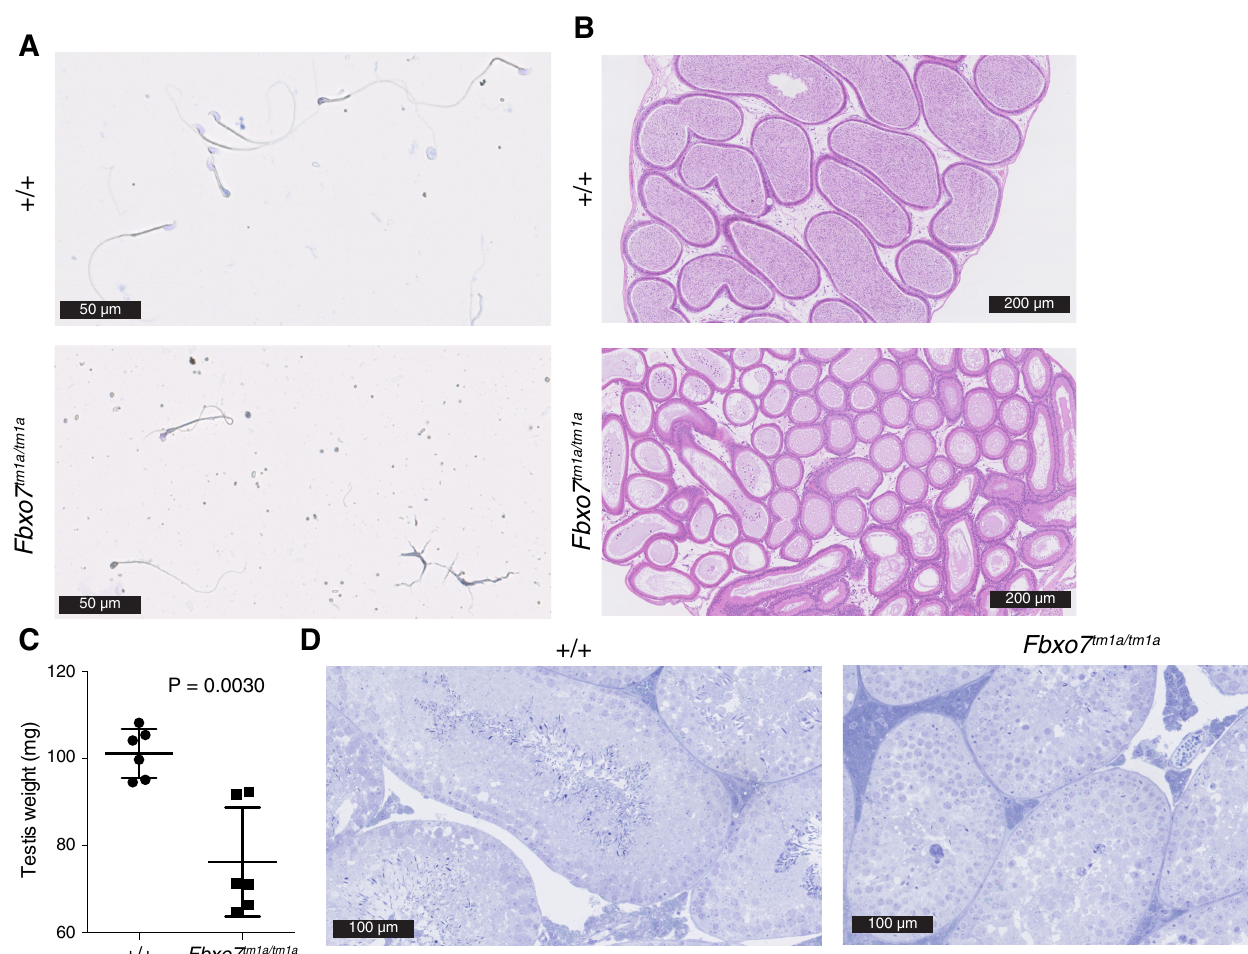
Fig 6. Defects in the testis and epididymis of Fbxo7 tm1a/tm1a mice. (A) Image of epididymal spermatozoa smear stained with hemacolor from 12-14-week-old mice. (B) H&E stained section of epididymis from 20-week-old mice. (C) testis weight from 18-19-week-old mice. (D) semithin toloudine blue stained section image of testis from 8-week-old mice. Images are representative of at least two mice per genotype, P value from an unpaired two-tailed students t test with Welch’s correction with each symbol representing a testis, line is at the mean and error bars represent standard deviation.